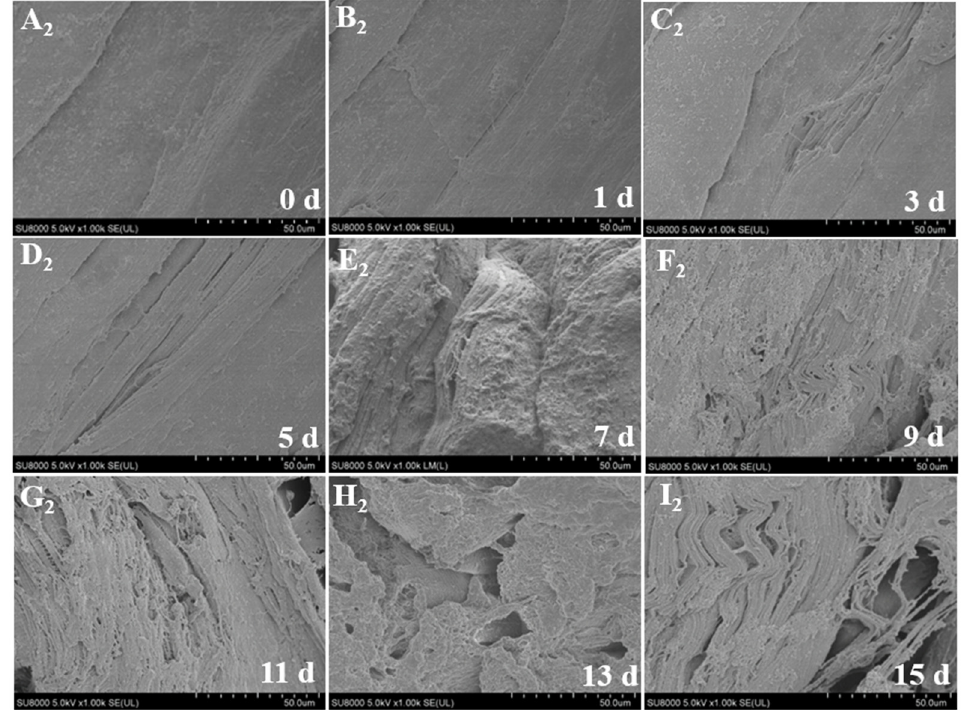
Figure 3. Changes in microstructure of Coregonus peled fillets under − 3 °C super chilling storage for 15 d. A 2 − I 2 indicate storage in –3 °C super chilling for 0 − 15 d.